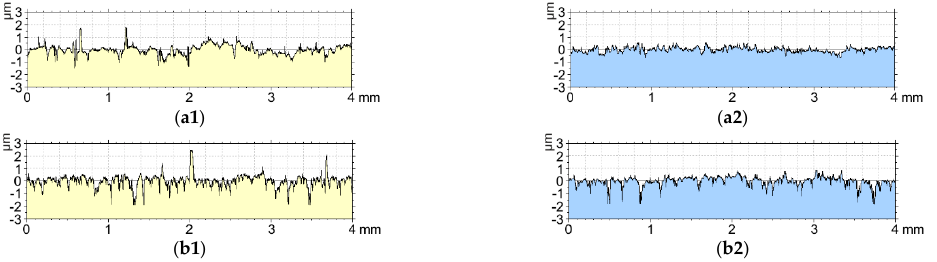
Figure 14. Roughness profiles: ( a ) sample E, ( b ) sample H, 1 —before the tribological test, 2 —after the tribological test.